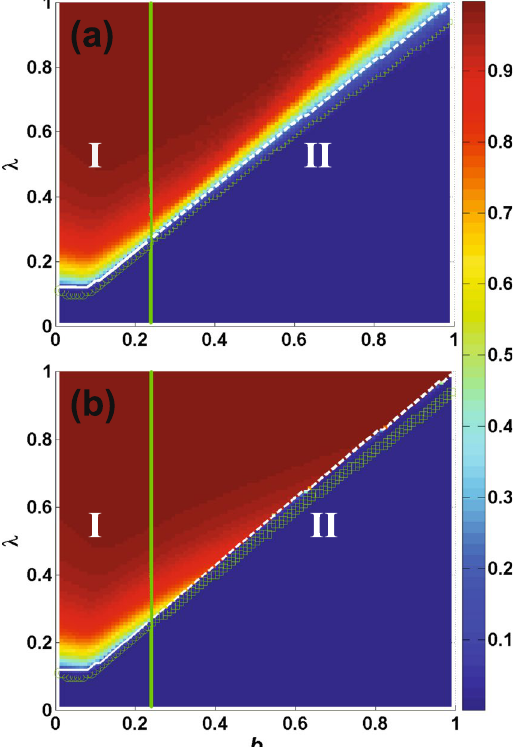
Figure 5. Dependence of the final adoption size R ( ∞ ) on b and λ on ER network. Color-coded values of R ( ∞ ) are obtained from numerical simulations ( a ) and theoretical solutions ( b ). Herein, the theoretical solutions are achieved through Eqs (2–4) and (9–16). The parameter plain is divided into two regions by b * which is obtained from Eqs (19), (20) and (23). In regions I , R ( ∞ ) shows a continuous increase and undergoes a second-order phase transition. In contrast, R ( ∞ ) exhibits a discontinuous increase and undergoes a first-order phase transition in region II . The solid white line from theoretical method and green circles from numerical II in region I . And the dashed white line from theoretical method and simulation all represent the critical λ c II in region II green rectangles from numerical simulation as well denote the the critical λ c